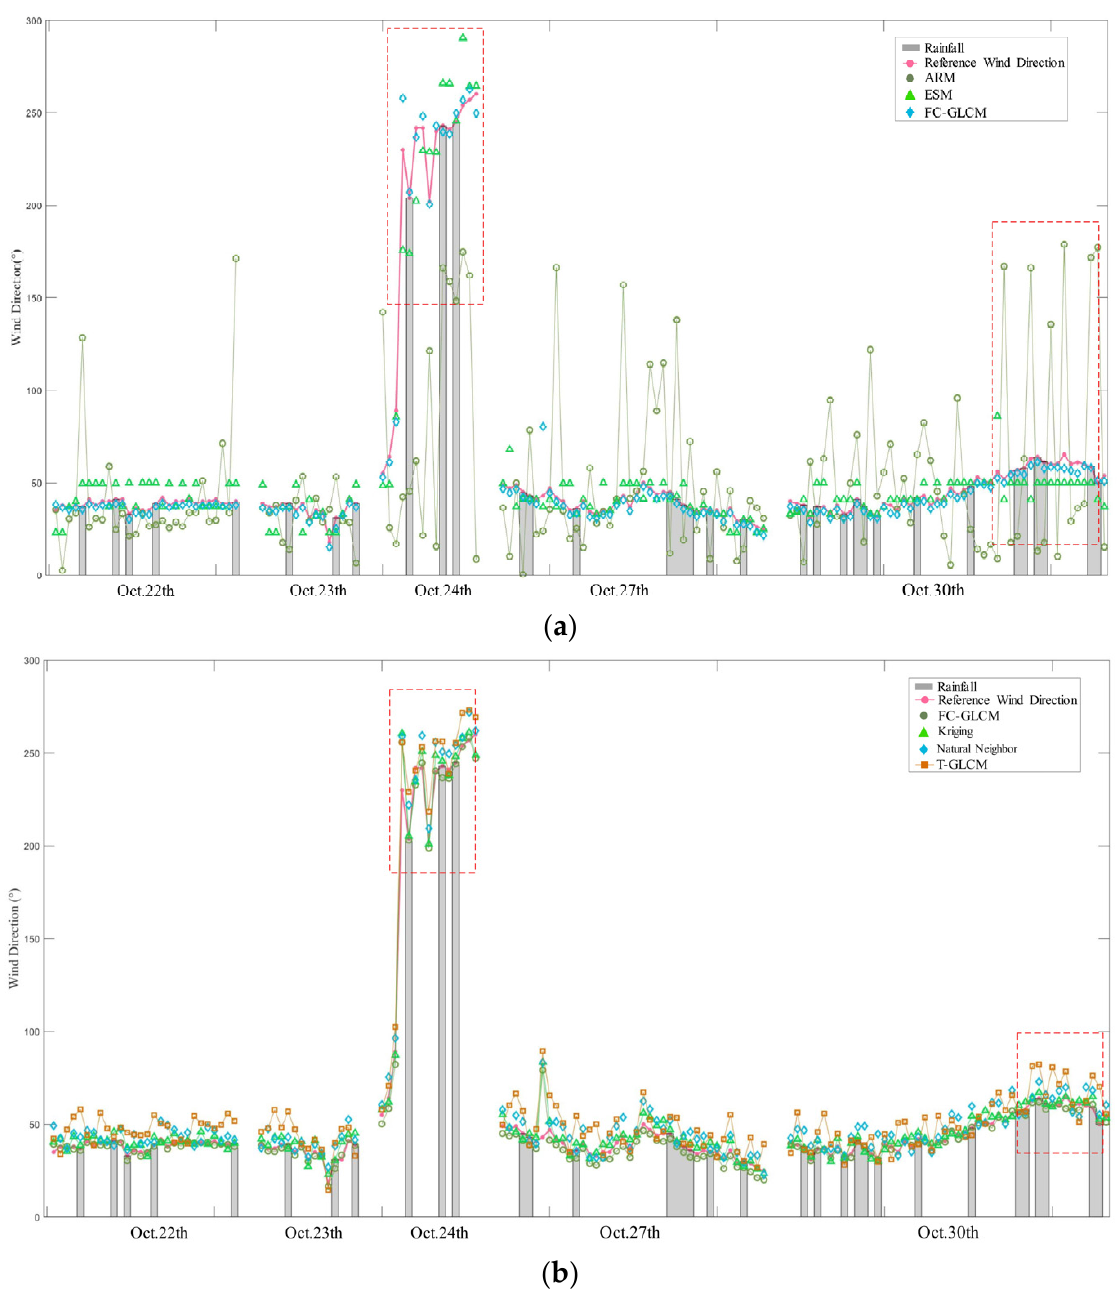
Figure 12. Comparison of the proposed FC-GLCM method results with different wind measurement techniques. (The pink curve with the open points represents the wind direction measured by the vane anemometer, the gray background area is the data during weak rainfall, and the red dotted boxes represent the data with large error during rainfall.) ( a ) Comparison of the proposed FC-GLCM method results with the Kriging, natural neighbor, and T-GLCM approaches. ( b ) Comparison of the proposed FC-GLCM method results with the ARM, ESM.